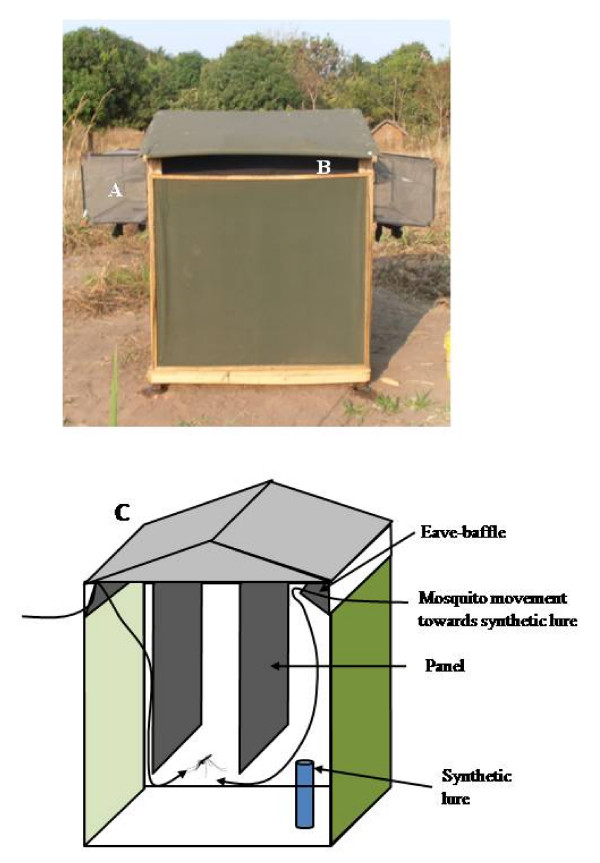
Picture of the odor-baited station fitted with (A) exit trap, (B) conidia treated baffles, and (C) schematic representation.